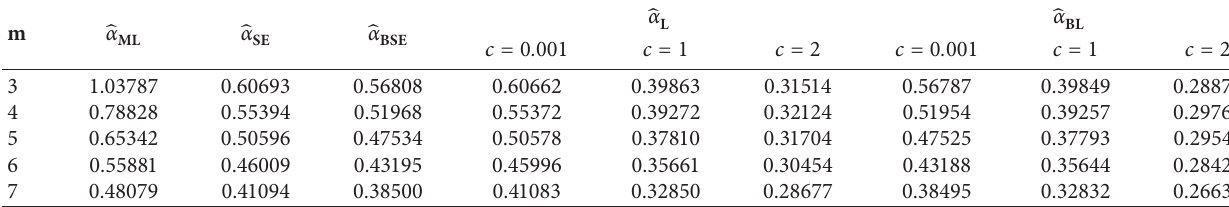
Table 1: Absolute bias of the estimates of α